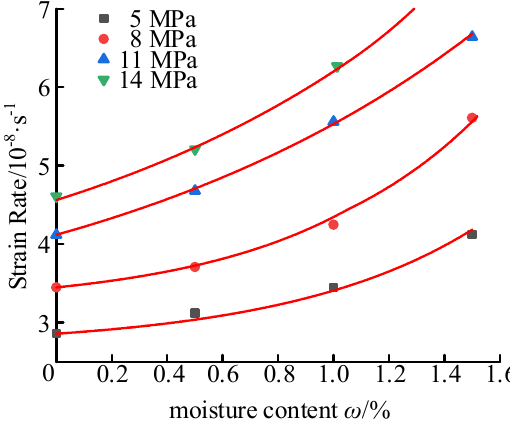
Figure 8. Strain rate–moisture content curve of coal-rock combination.